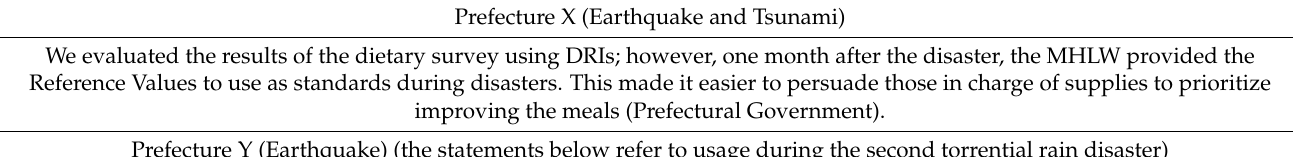
Table 3. How and for what were the Reference Values used? (Q1).